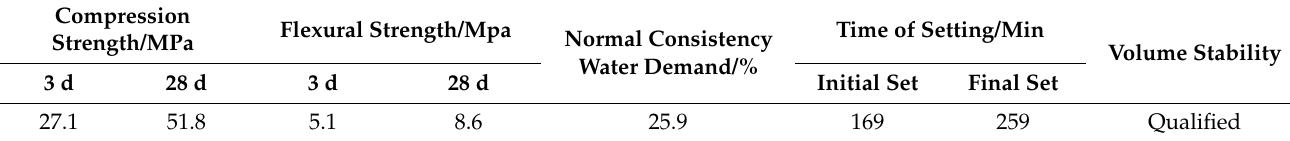
Table 2. Main technical properties of the cement.